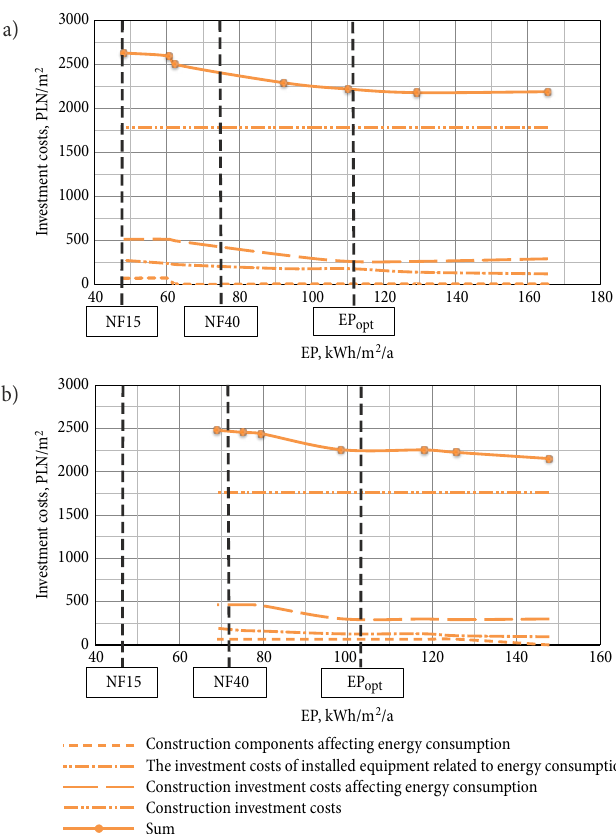
Fig. 5. Characteristics of investment costs for the reference buildings and gas condensing boilers: BSC_1; b –